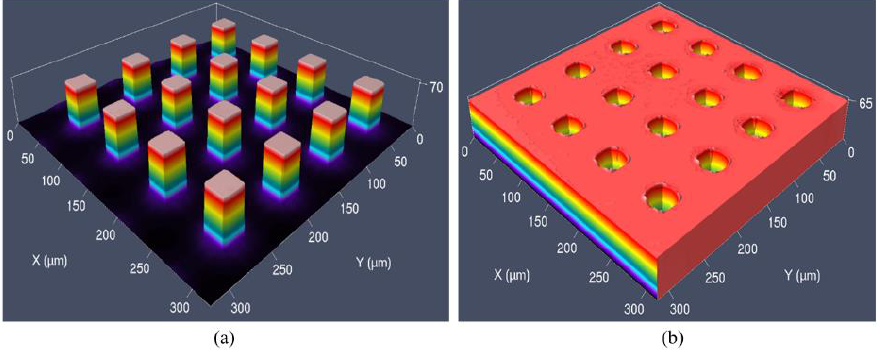
Figure 5. The microstructure arrays on both ( a ) Si master; ( b ) Ni mold insert by the confocal micro- scope